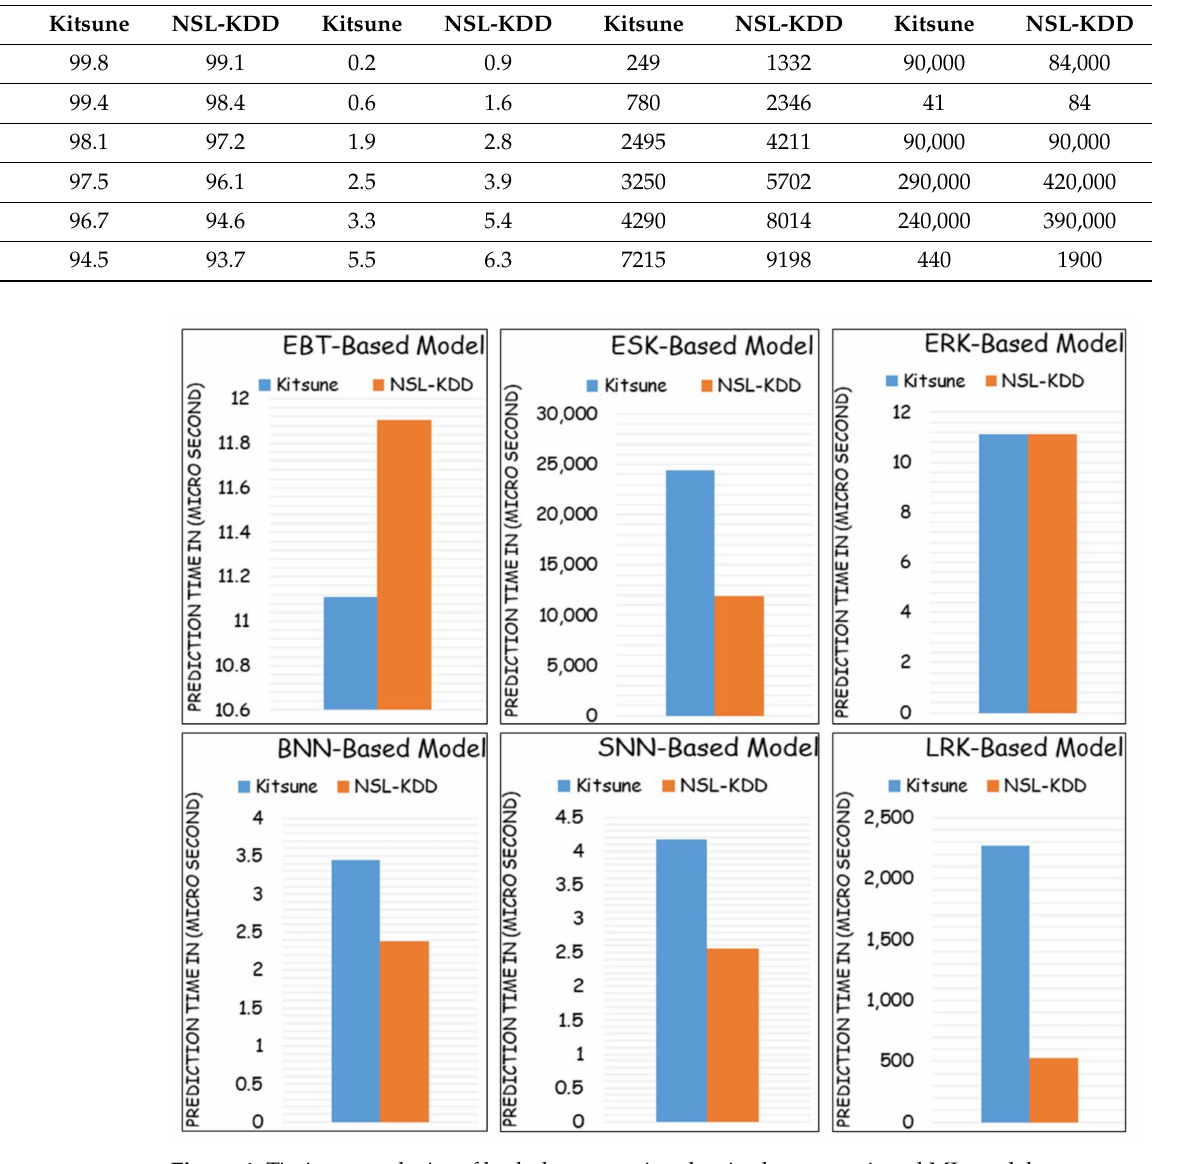
Figure 4. Timing complexity of both datasets using the six above mentioned ML